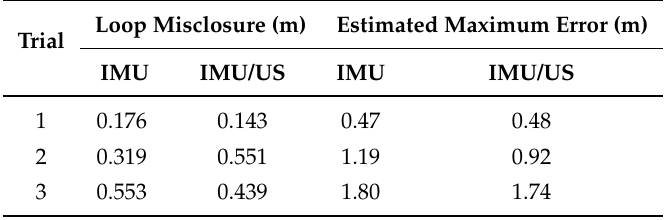
Table 3. The loop misclosure and estimated maximum errors of inertial measurement unit (IMU) and IMU/ultrasound (US) systems for all three trials during Type 2